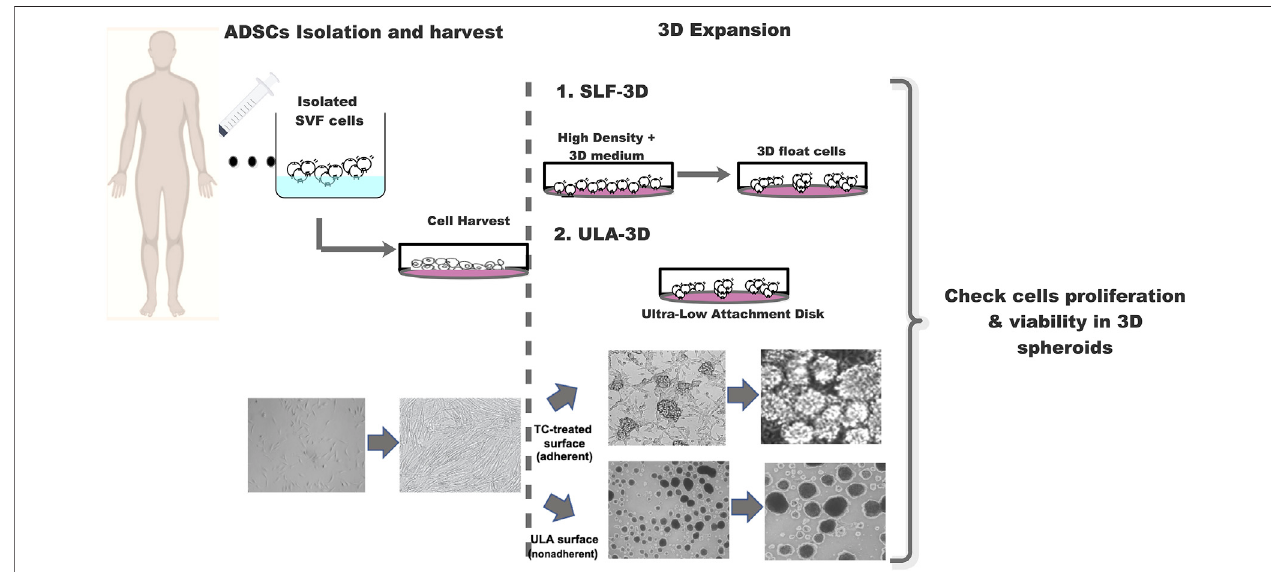
FIGURE 1 | Schematic diagram of the strategy for 3D-cultured adipose stem cells. Schematic diagram SLF-3D form spheroids and assay method. Morphological observation of 3D spheroid formation. Phase-contrast images of cell expansion at low density, high density, and 3D spheres.